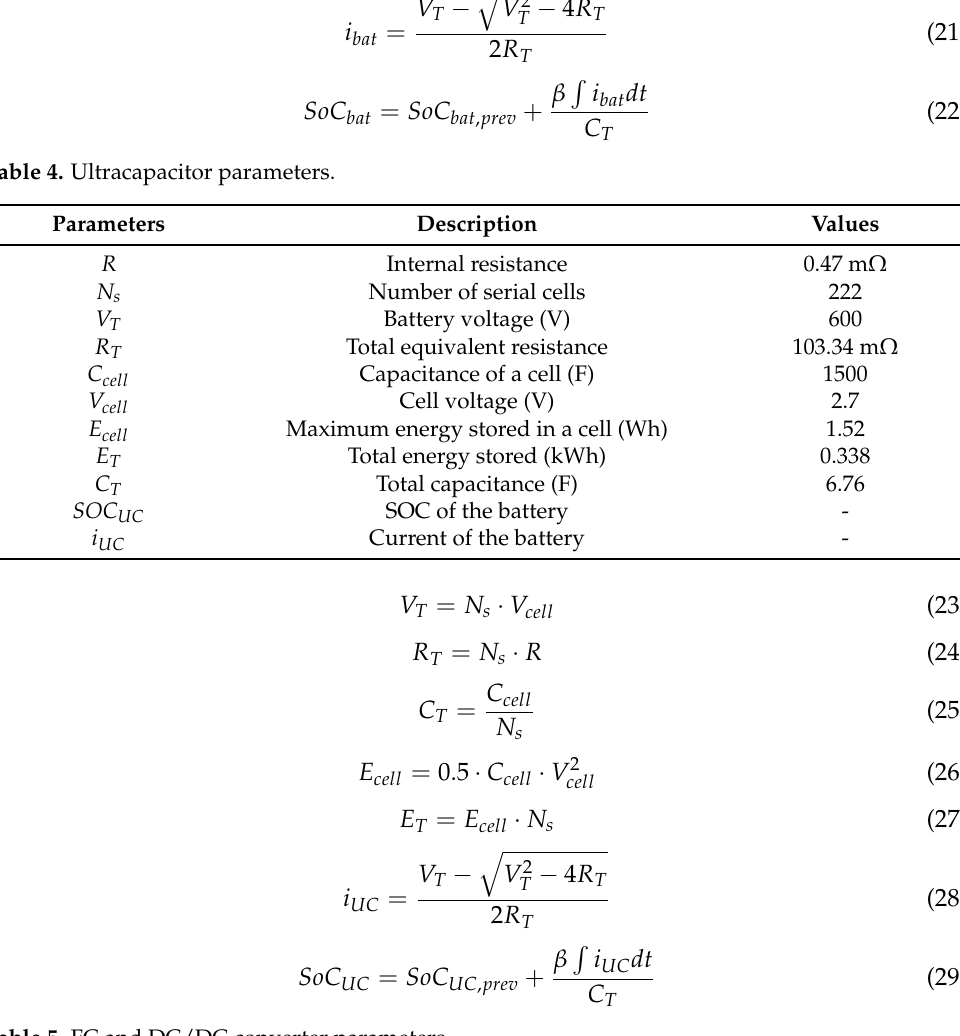
Table 5. FC and DC/DC converter